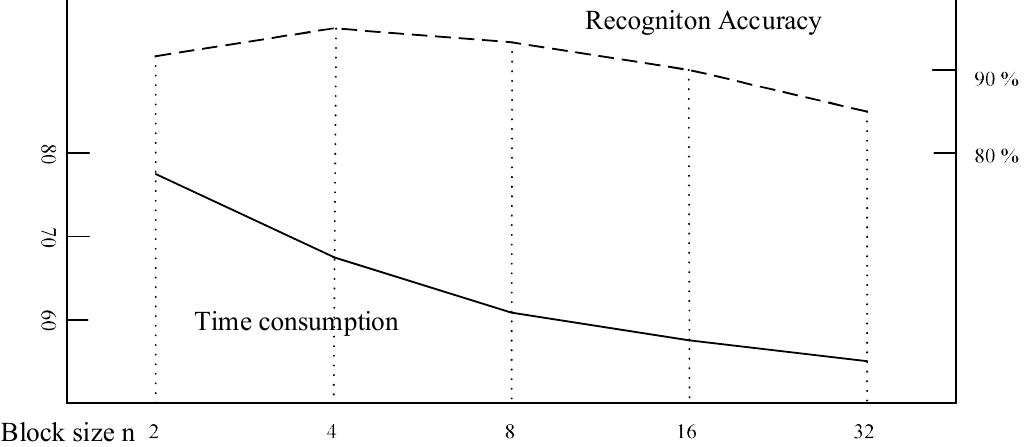
Figure 15. Variation of time consumption and recognition accuracy with a change of block size n.